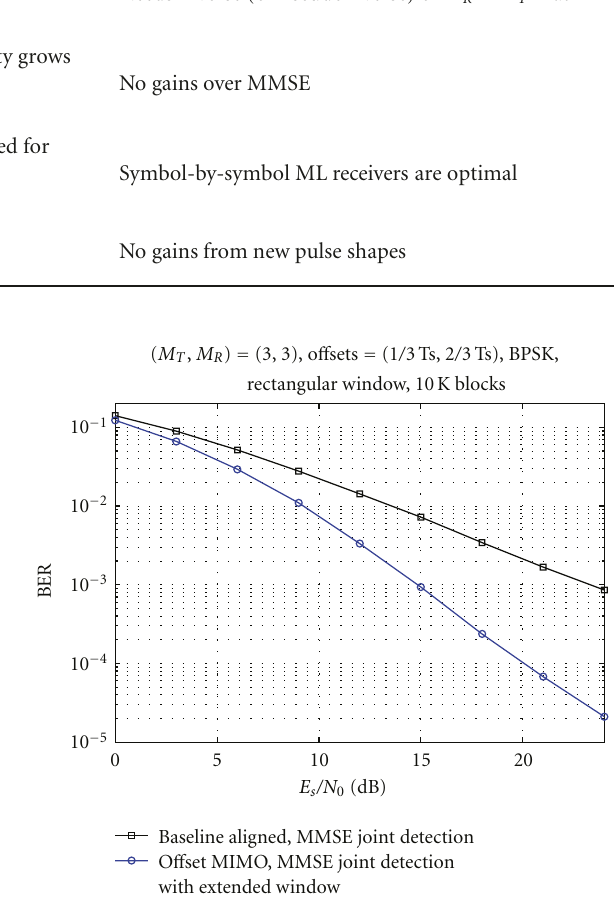
Figure 14: Performance of a 3 × 3 system, ( M T , M R ) = (3,3), modulation =